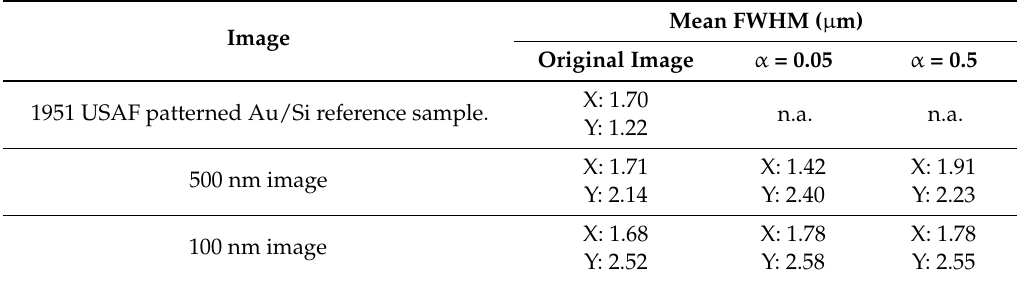
Mean FWHM ( µ m) Original Image α = 0.05 α = 0.5